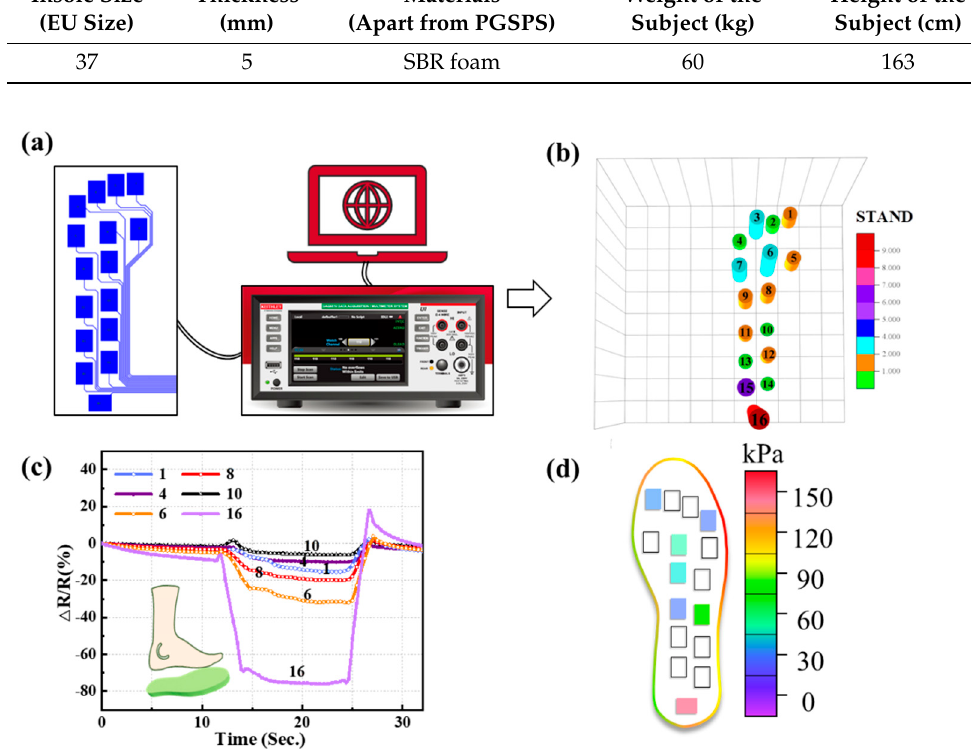
Figure 5. ( a ) Diagram of gait testing using commercial instruments. ( b ) Pressure nephogram of the in-shoe system with an adult standing on it. ( c ) Test results of six sensing points (1, 4, 6, 8, 10, and 16) at static stations. ( d ) Pressure map reconstructed from ( c ). Table 3. The characters of the insole and the subject condition.